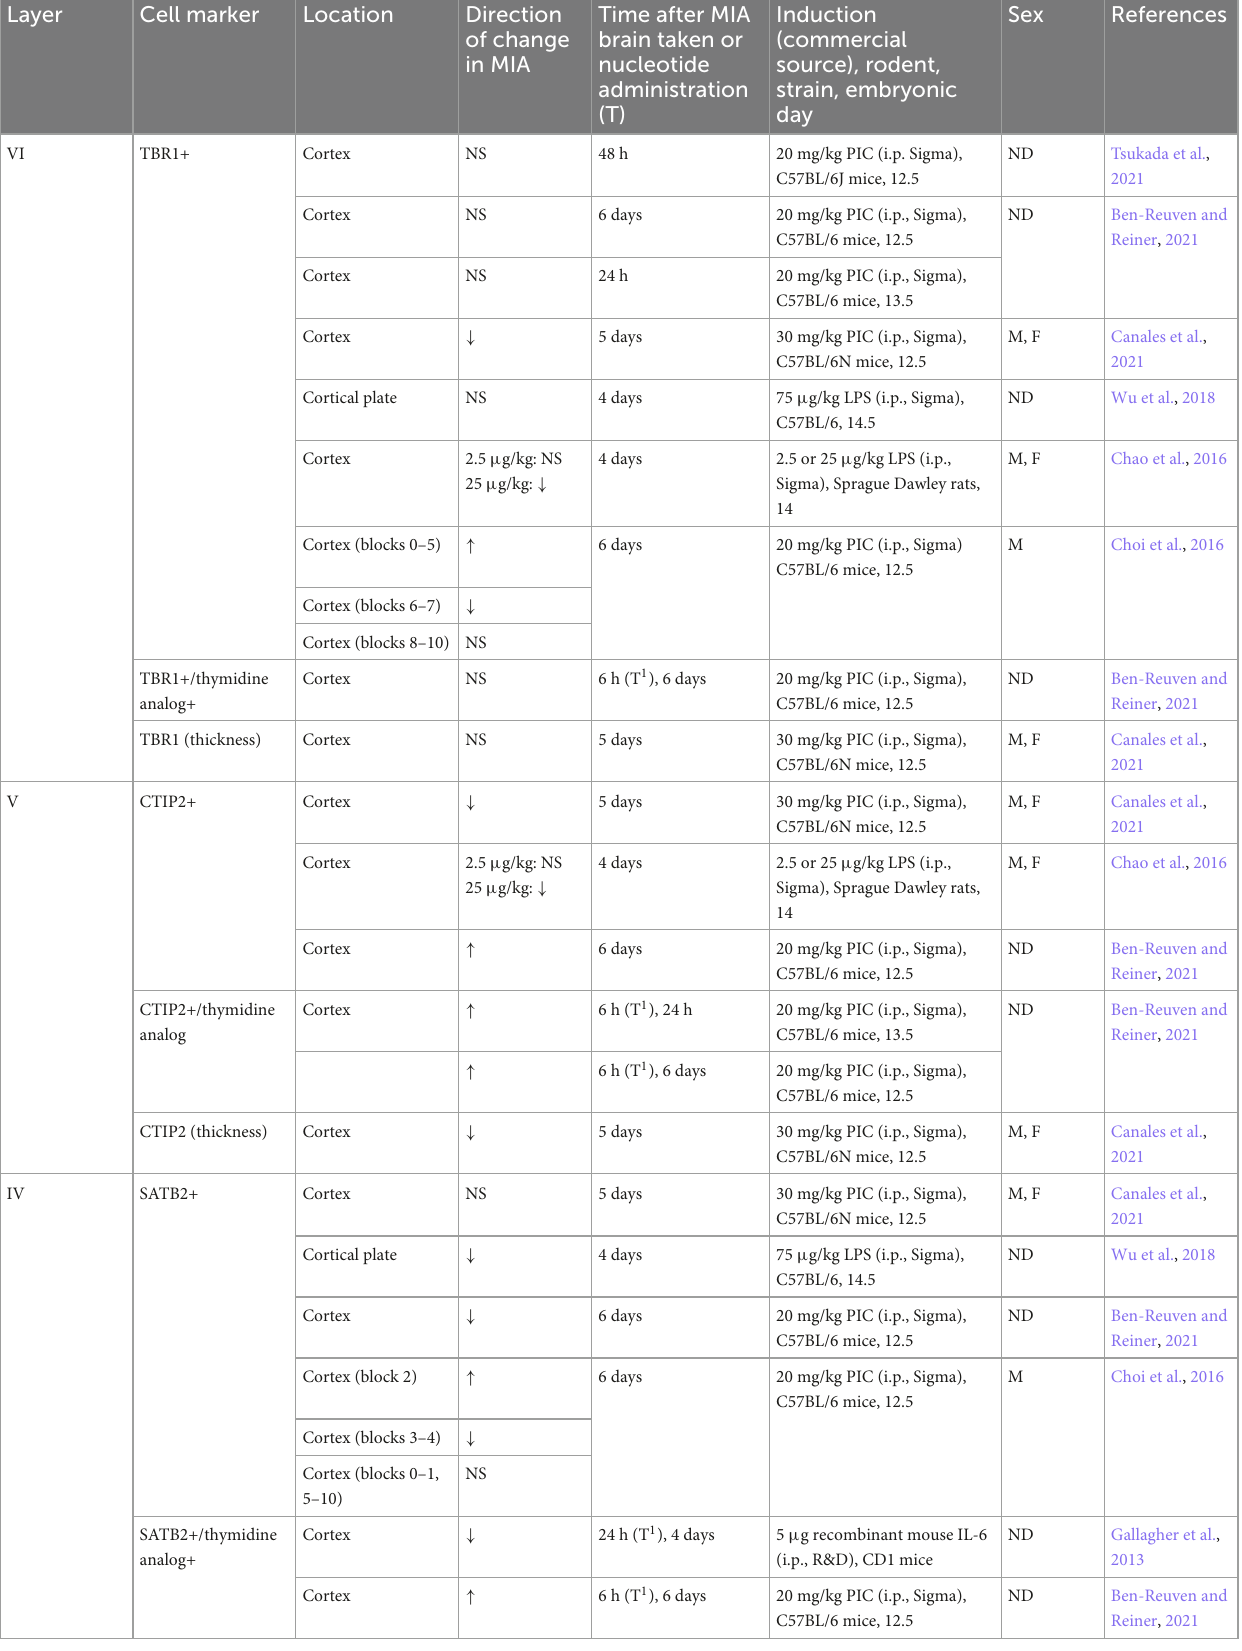
TABLE 3 Cortical lamination changes in MIA fetal offspring brains in contrast to vehicle controls. Layer Cell marker Location Direction